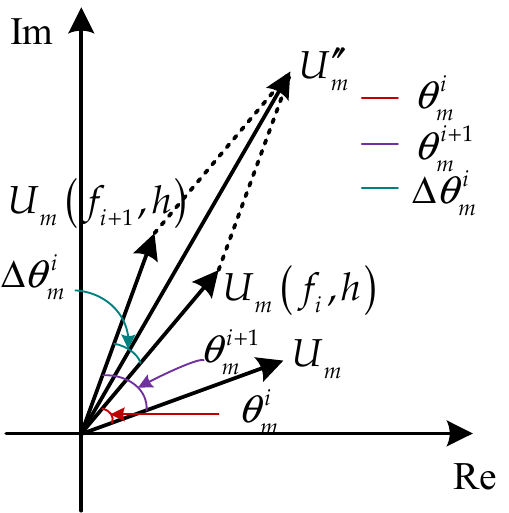
Figure 4. Schematic diagram of diffraction field vector superposition of segmented phase grating. Firstly, conditions are analyzed when U m has the maximum amplitude based on Equations (4) and (5). Figure 5 illustrates the diffraction efficiency η m as a function of duty cycle f and groove depth h . As shown in Figure 5a–j, when h is a multiple of a half wavelength, the diffraction efficiency η 0 of the zeroth order is r 2 , and the diffraction efficiency η m of other orders is equal to zero. When the product of m and f is an integer, the m th order is absent. For example, when f is 1/5, η 5 = 0. When h and f meet the following conditions at the same time: